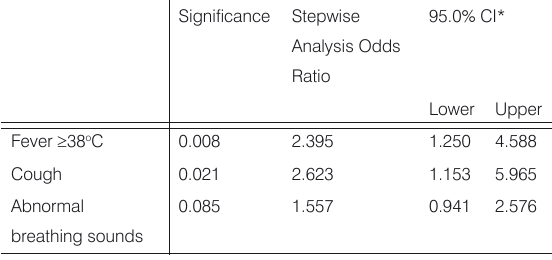
Table 3. Multivariate predictors of influenza infection in